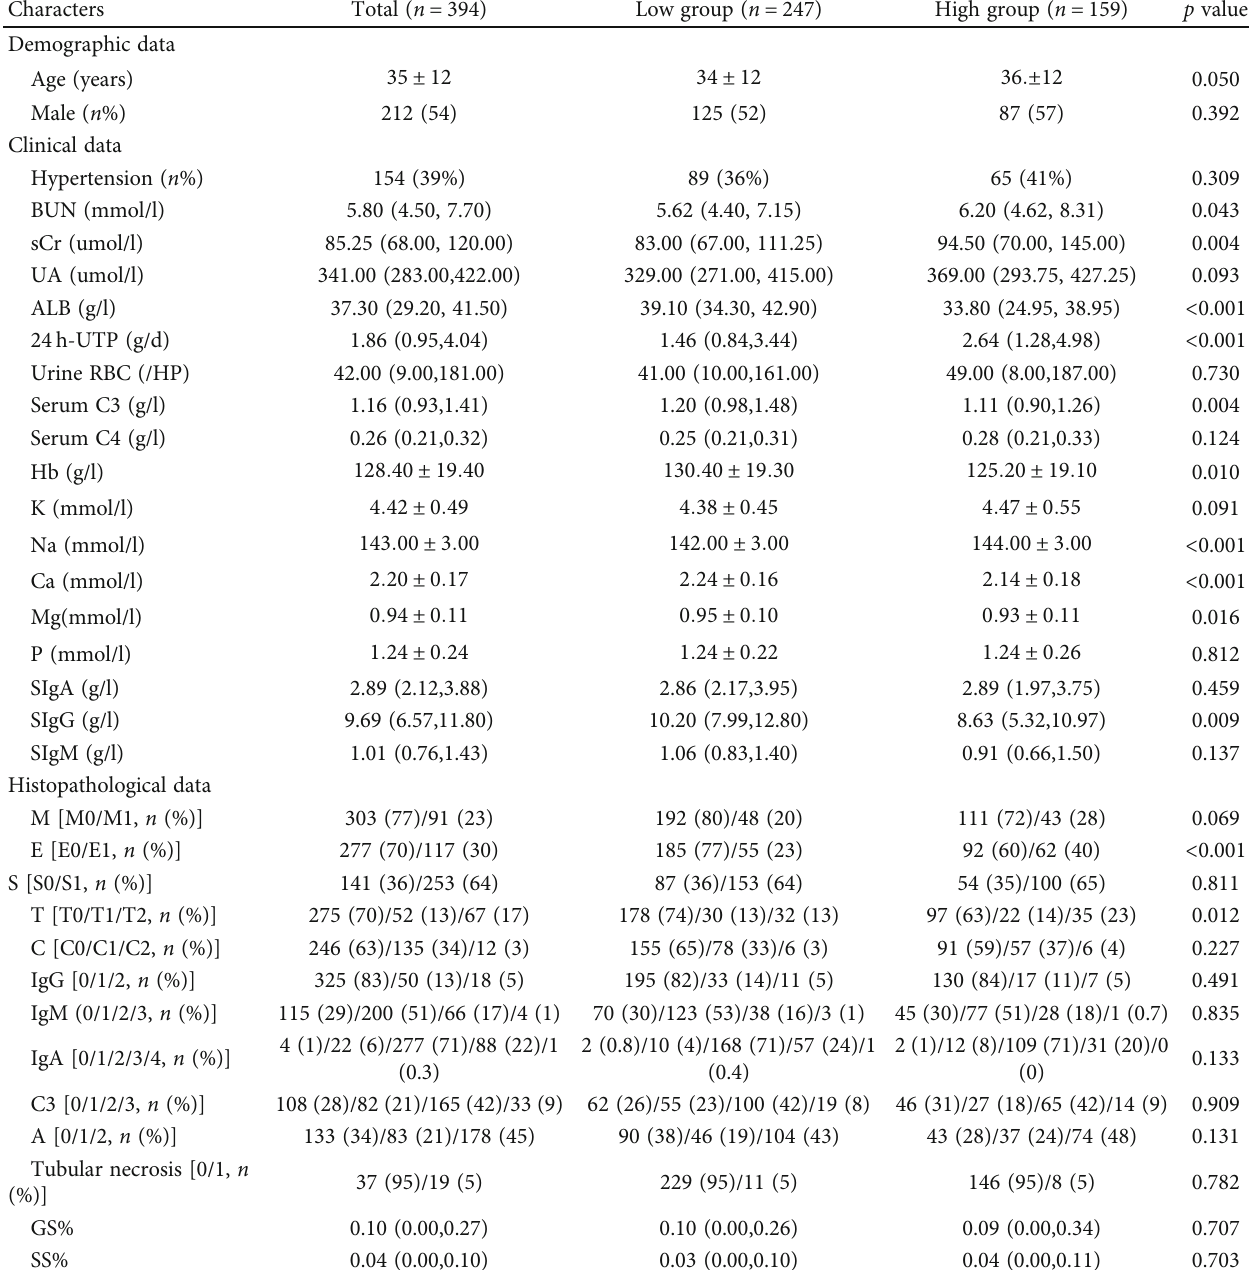
Table 1: Relationship between the serum chloride and demographic, clinical, and pathologic